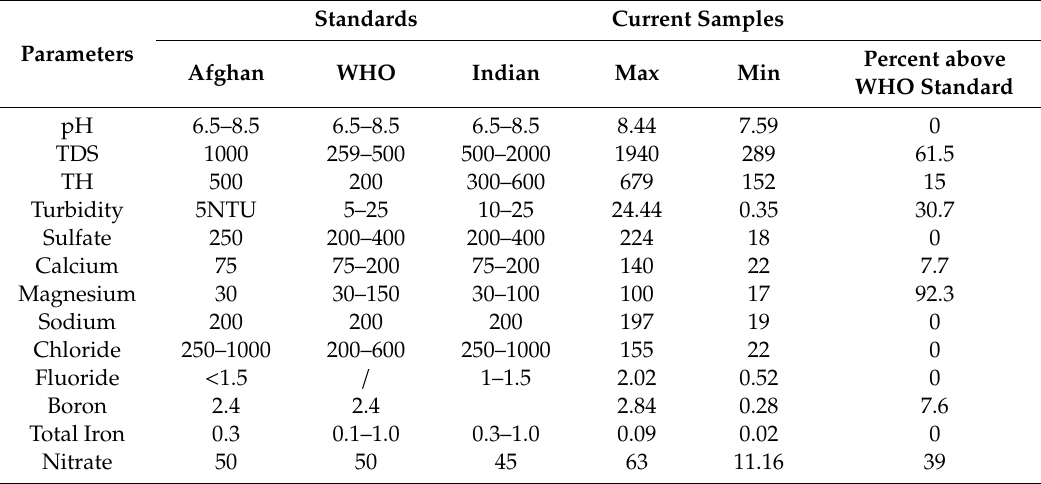
Table 8. Comparison of assessed parameters with Afghan, WHO, and Indian standards